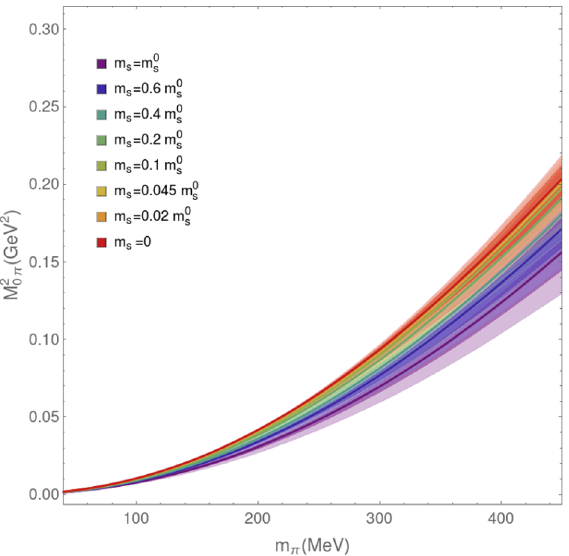
Figure 15 . The squared leading order mass, M 2 di(cid:11)erent values of the strange-quark mass, m s